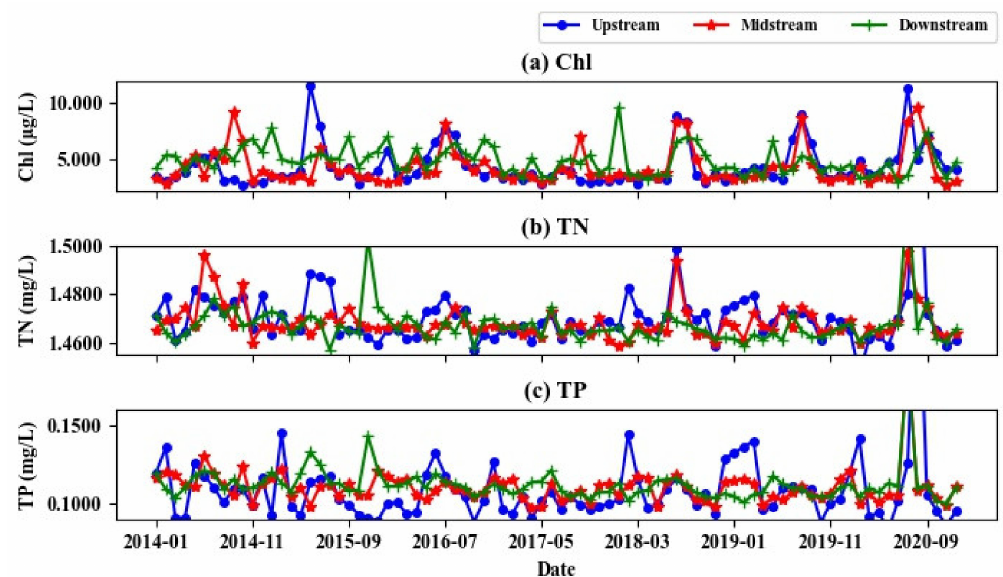
Figure 7. Comparison of ( a ) Chl-a, ( b ) TN, and ( c ) TP concentrations in upstream, midstream, and downstream of the Yangtze River.